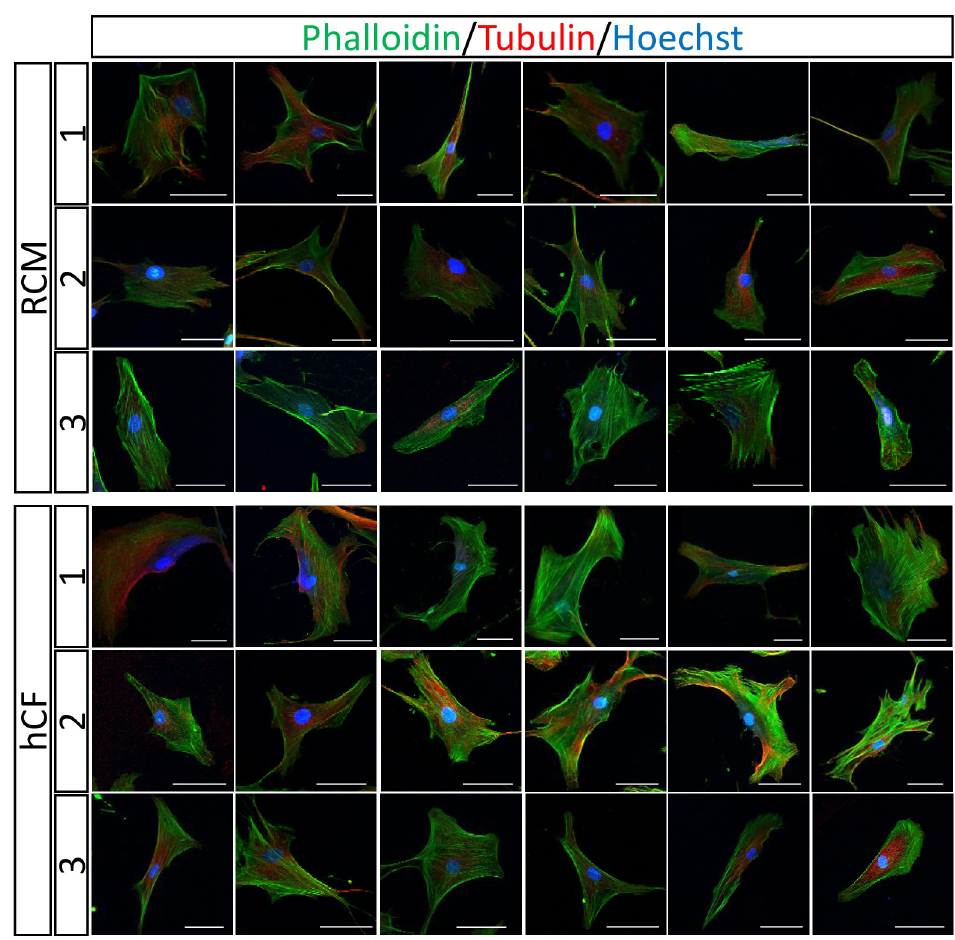
Fig 4. Immunocytochemistry of cellular cytoskeletal components in cardiac fibroblasts (CFs). Representative images of immunocytochemistry for actin filaments (phalloidin) and tubulin in RCM CFs and healthy CFs. The numbers represent the individuals. Scale bar: 50 μ